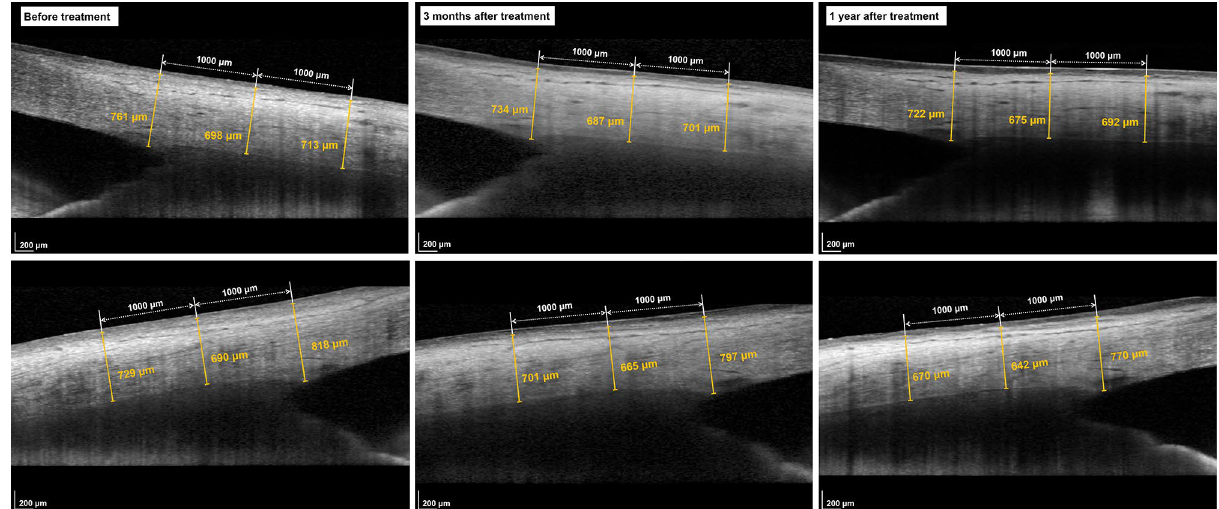
Figure 1. Representative case demonstrating anterior scleral thickness reduction after using prostaglandin analog for 1 year. (Top, nasal sector; Bottom, temporal